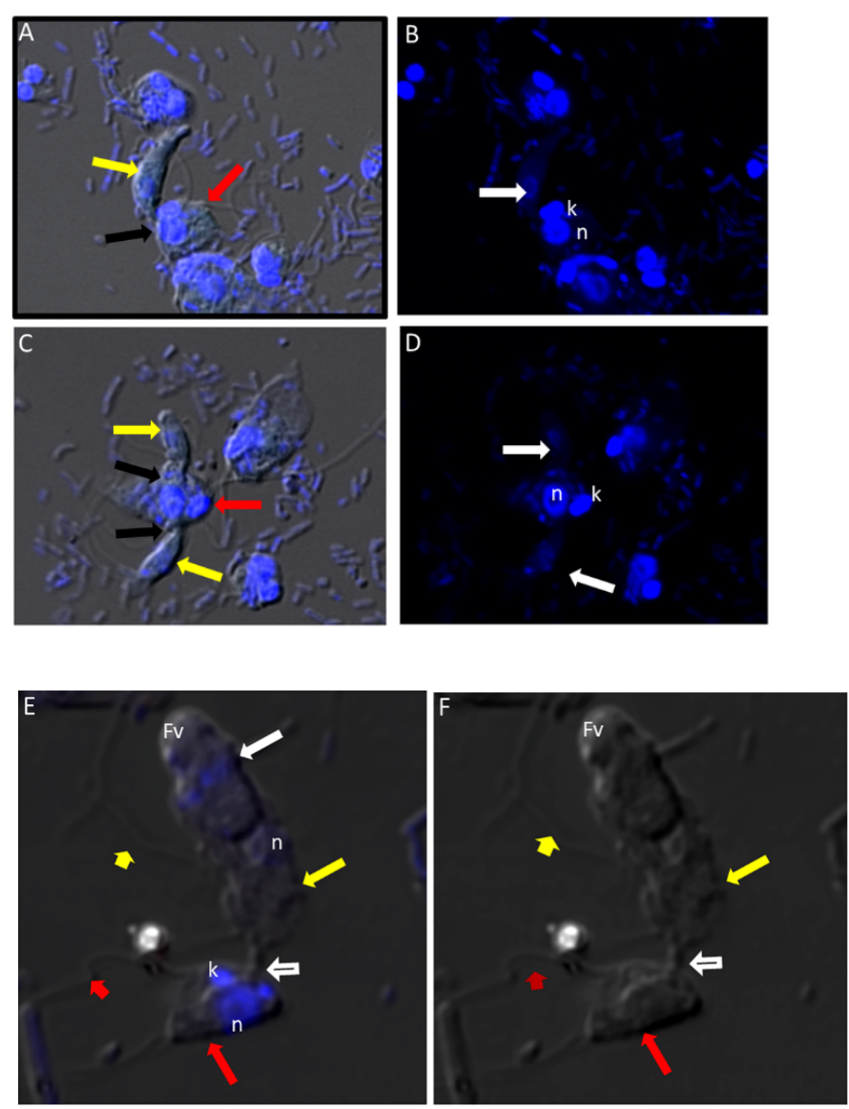
Figure 4. ( A – D ): Differential Interference contrast (DIC) microscopy of DAPI stained Colpodella sp. (ATCC 50594) life cycle stage transitions. ( A , C ) Merger of DIC and DAPI stained Colpodella sp. (ATCC 50594) trophozoites (yellow arrow) and P. caudatus prey (red arrow) in myzocytosis. Two predators feeding on one prey are shown in panel ( C ). The tubular tether joining predator and prey is indicated by the black arrow. ( B , D ) DAPI stained nuclei and kinetoplast. The kinetoplast (k) and nucleus (n) of P. caudatus is identified in panels ( B ) and ( D ). The central nucleus of Colpodella sp. (ATCC 50594) trophozoites is indicated by the white arrows. ( E , F ): Differential Interference contrast (DIC) microscopy of DAPI stained Colpodella sp. (ATCC 50594) life cycle stage transitions. ( E ) Merger of DIC and DAPI. ( F ) DIC alone. Colpodella sp. (ATCC 50594) trophozoite (yellow arrow) shown in myzocytosis with P. caudatis (red arrow). The tubular tether between predator and prey is indicated by the open arrow. DAPI stained aspirated contents can be seen at the posterior food vacuole of the Colpodella sp. (ATCC 50594). Yellow arrowhead identifies the flagella of Colpodella sp. (ATCC 50594) and the flagella of the prey are indicated by the red arrowhead. The kinetoplast (k) and nucleus of the prey and the nucleus of Colpodella sp. (ATCC 50594) were